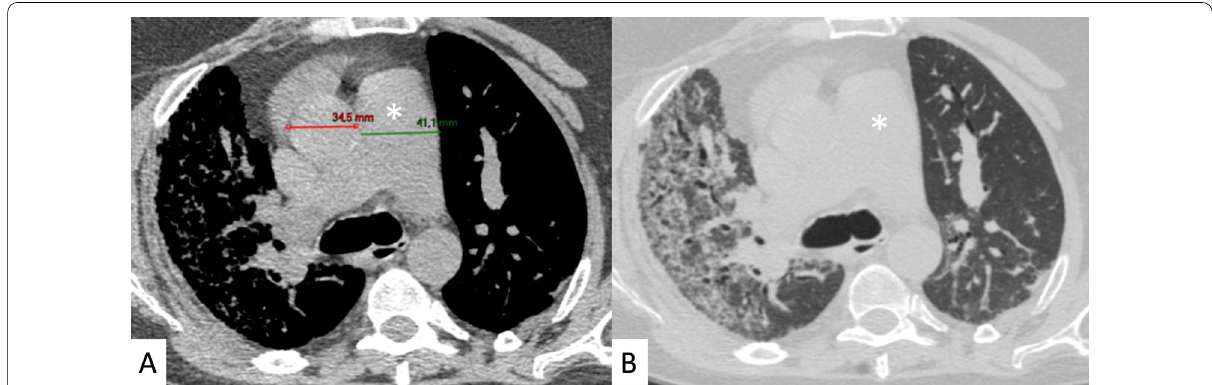
Fig. 13 A patient with pulmonary hypertension (PH) assessed by chest CT. A Mediastinal window preset of visualization and ( B ) lung windowing preset of visualization clearly demonstrate the enlargement of the pulmonary trunk (white asterisk); commonly, the main pulmonary artery/ ascending aortic/ratio is calculated. Generally, normal values are less than 1.0, whereas in cases of superior values, PH may be